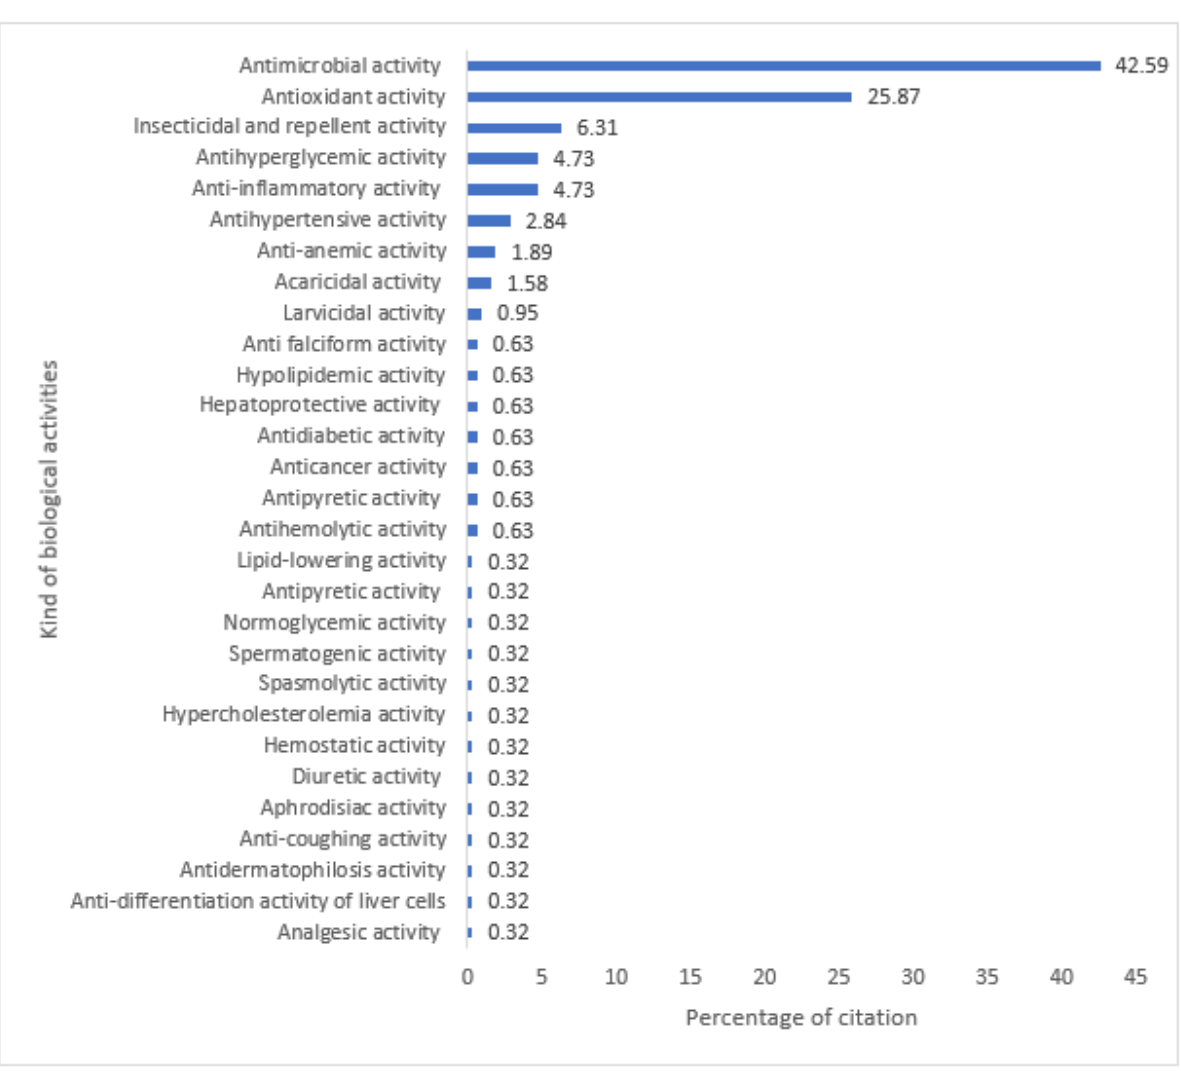
Figure 1. Summary of pharmacological studies carried out on different medicinal plants.